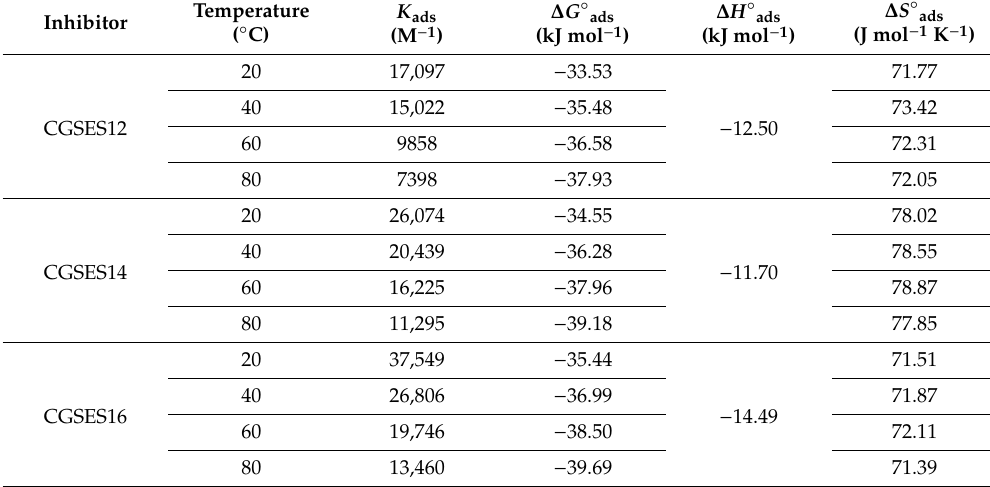
Table 7. Standard thermodynamic parameters of adsorption on the MS surface in 1 M HCl containing di ff erent concentrations of the synthesized cationic gemini surfactants.